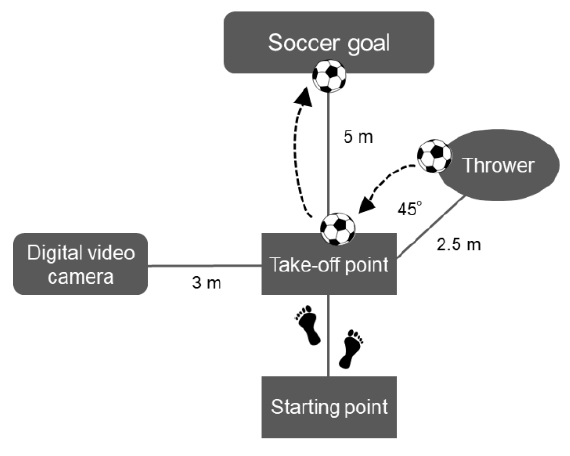
Figure 1. Experimental task.